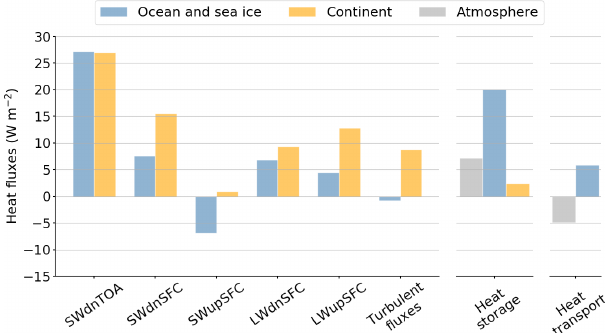
Figure 9. Quantification of the LIG–PI anomalies of the sur- face heat fluxes (left), storage terms (centre) and oceanic and at- mospheric heat transport (right) for summer. Each flux included in the surface heat budget computation is plotted: solar radiation received at the surface (SWdnSFC), solar radiation reflected by the surface (SWupSFC), longwave radiation emitted by the sur- face (LWupSFC), longwave radiation emitted by the atmosphere (LWdnSFC) and turbulent fluxes given as the sum of latent and sen- sible heat fluxes. Variables are averaged between 60 and 90 ◦ N. The surface heat flux anomalies are positive when the flux is stronger during the